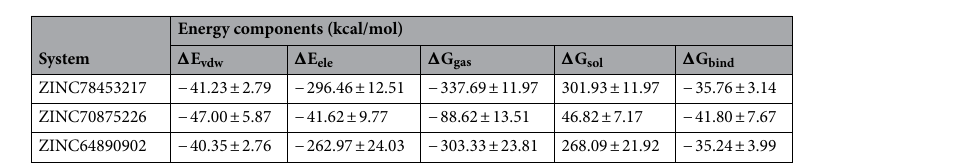
Table 5. Binding energy profile of hit compounds. ΔE ele = electrostatic energy; ΔE vdW = van der Waals energy;